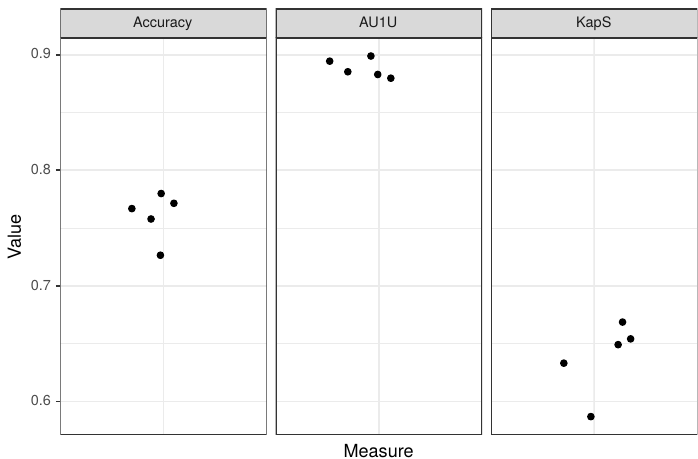
Figure 4. Results of fivefold cross-validation for the peptide layer of the model. Each dot corresponds to a single fold.